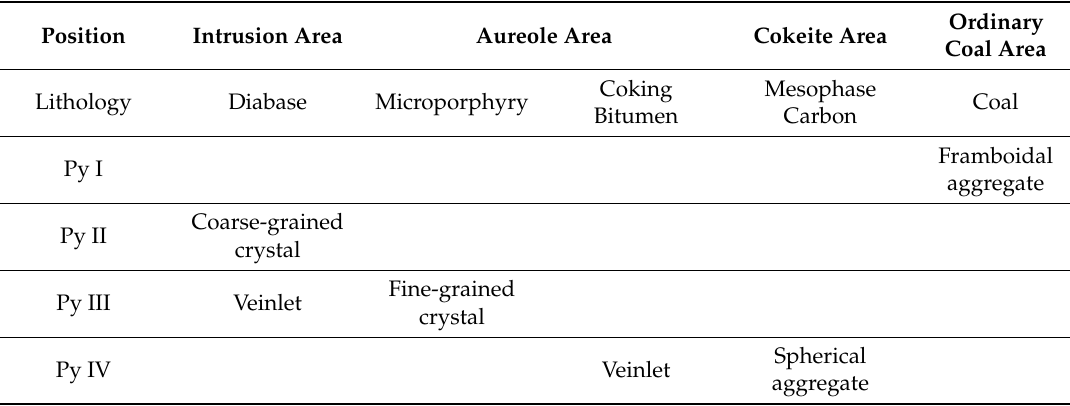
Table 3. Occurrences of the different pyrite generations from the Yuandian coal mine. Position Intrusion Area Aureole Area Cokeite Area